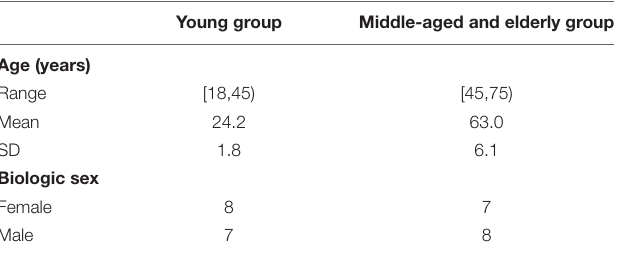
The temperature changes are 4, 4, and 6 ◦ C, respectively. The sum of the temperature changes of the other 29 sliding buttons for 3 adjustment tasks is also 14 ◦